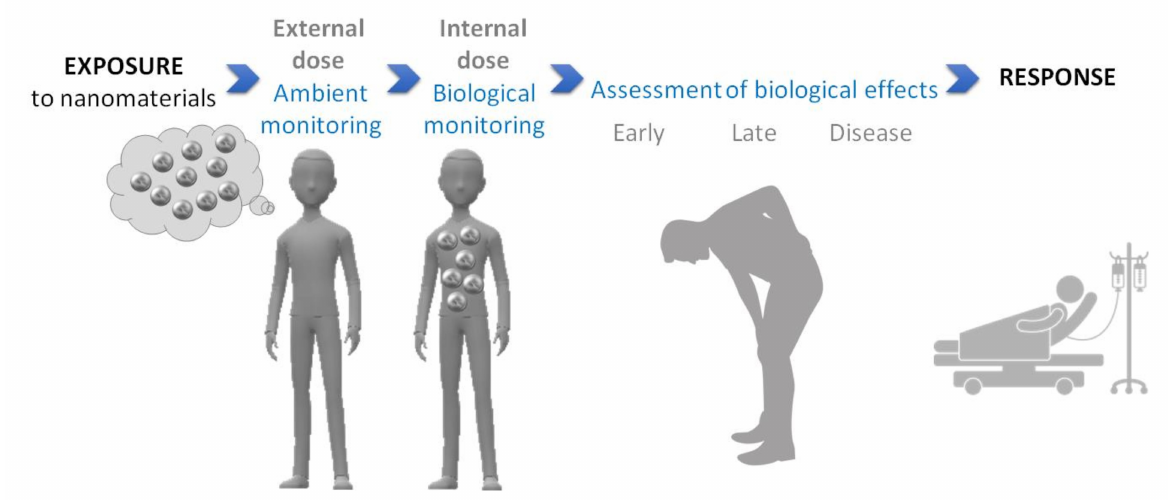
Figure 1. Biological monitoring of nanomaterials in human samples could fill a gap and help better understand the relationship between exposure to nanomaterials and adverse effects through the analysis of both biomarkers of exposure and biomarkers of